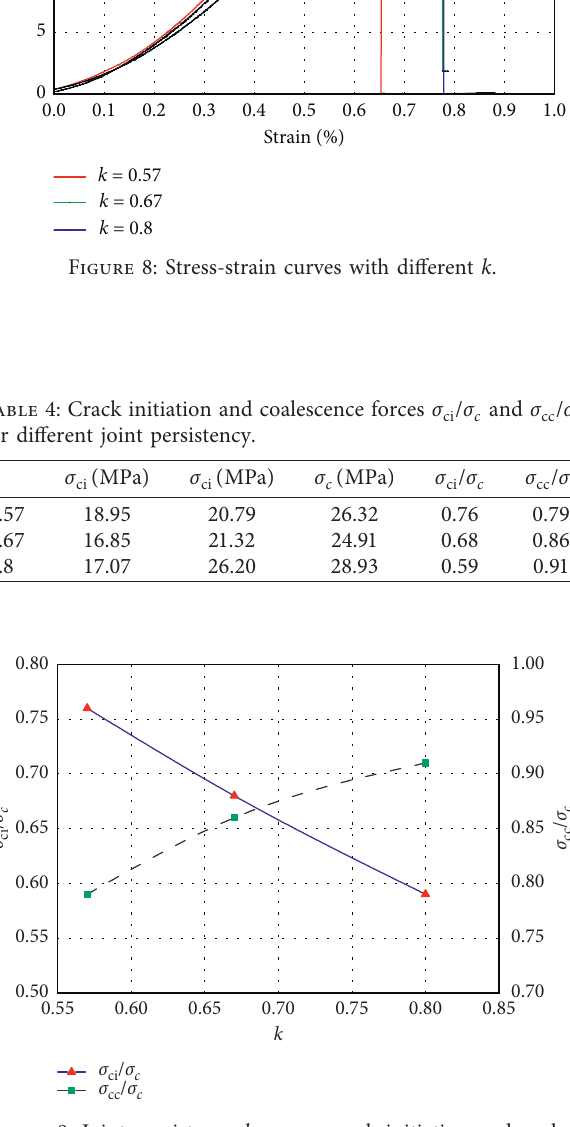
/ σ c and σ / σ c ci cc